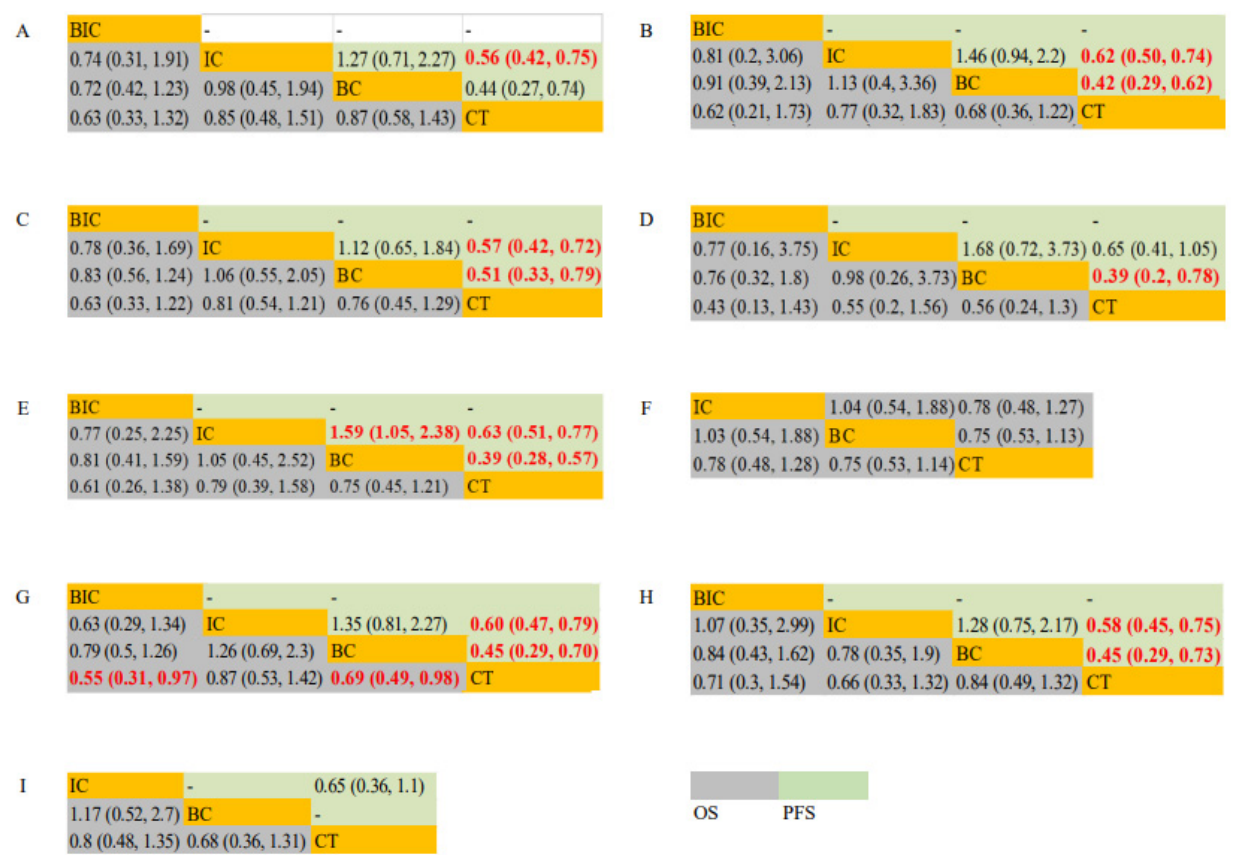
Figure 4. OS and PFS for study cohort in the subgroup analysis based on ECOG = 0 ( A ), ECOG = 1 ( B ), smokers ( C ), non-smokers ( D ), age < 65 ( E ), age ≥ 65 ( F ), male ( G ), female ( H ) and liver metastasis ( I ) according to network meta-analysis. Each cell contains the pooled Hazard Radio (HR) and 95% credibility intervals for OS and PFS; significant results are indicated in red. credibility intervals for OS and PFS; significant results are indicated in